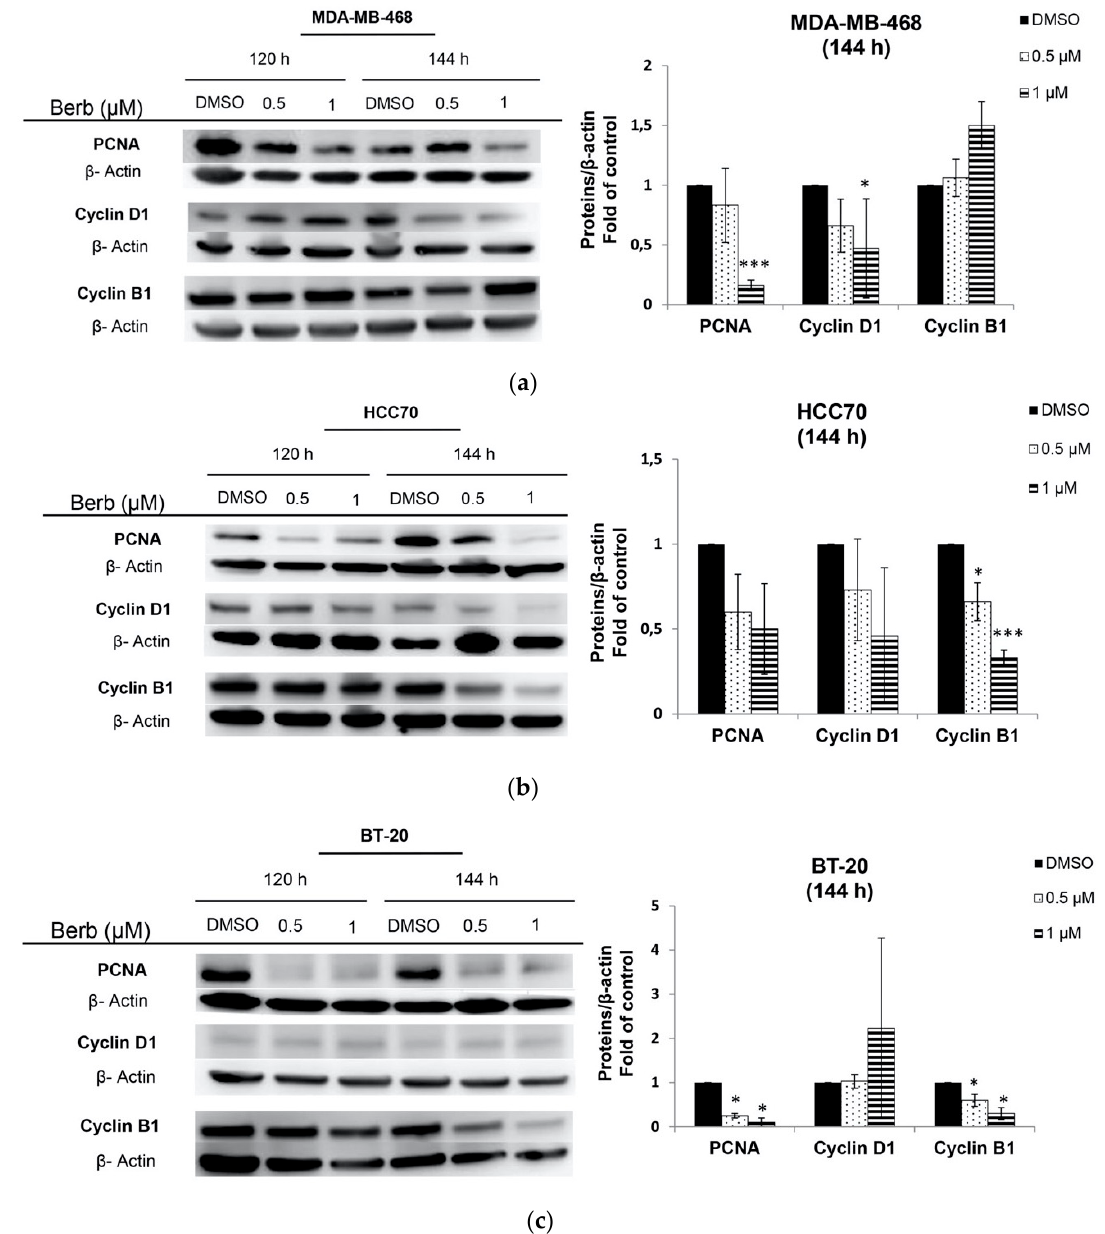
Figure 4. Representative Western blot results, of the expression of cell cycle related proteins PCNA, Cyclin D1 and Cyclin B1 of ( a ) MDA-MB-468, ( b ) HCC70 and ( c ) BT-20 treated with berberine at 0.5 and 1 µM for 120 h and 144 h. Results of three independent experiments ± SD, * p < 0.05, ** p < 0.01 and *** p < 0.001 compared to DMSO, Berb—Berberine.